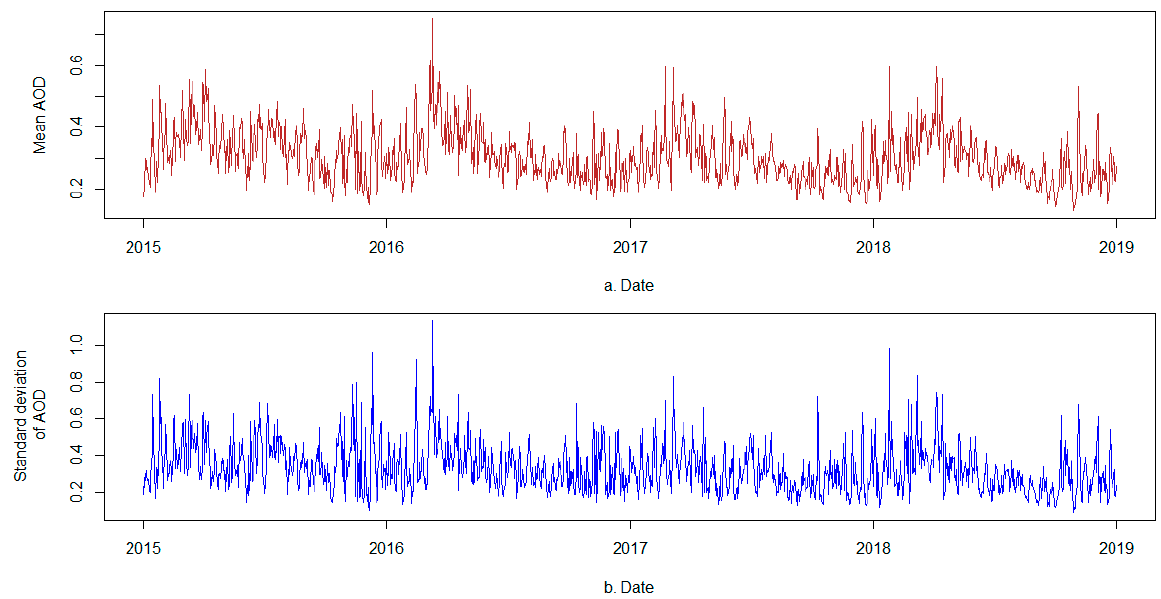
Remote Sens. 2021 , 13 , x FOR PEER REVIEW